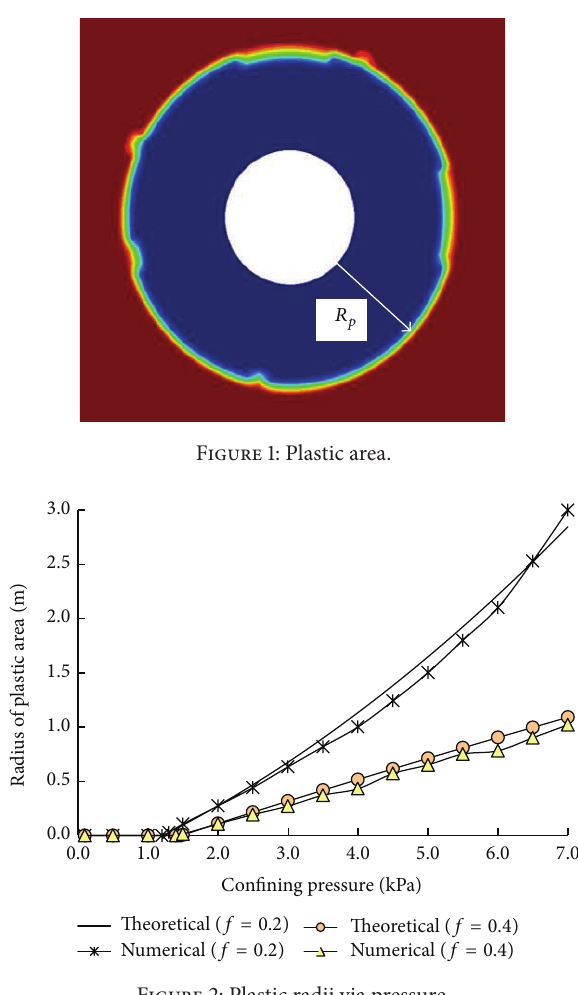
Figure 2: Plastic radii via